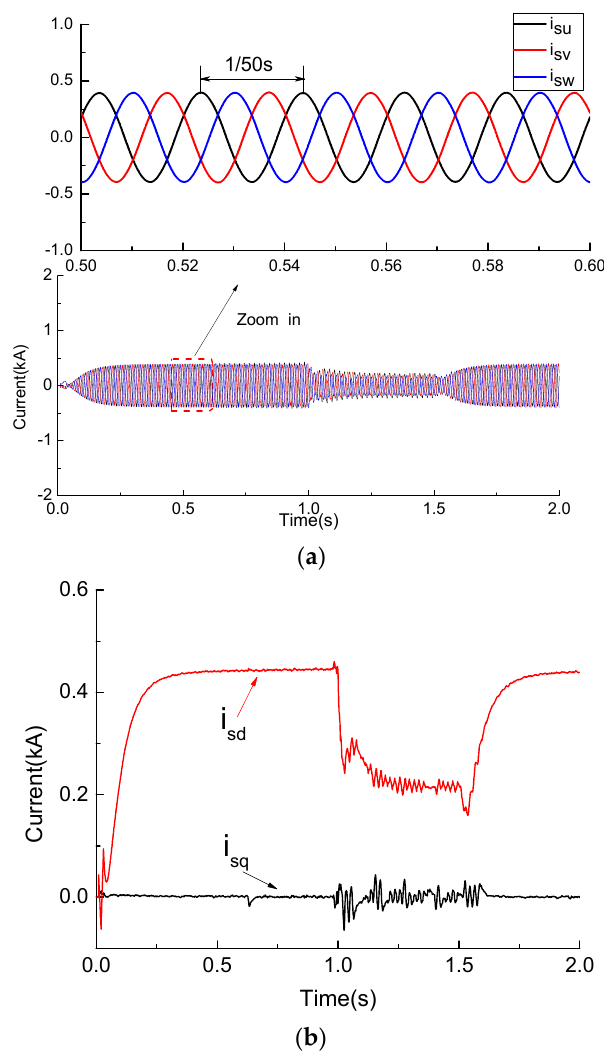
Figure 15. Current waveforms of the primary side system: ( a) system currents; ( b ) d–q waveforms.